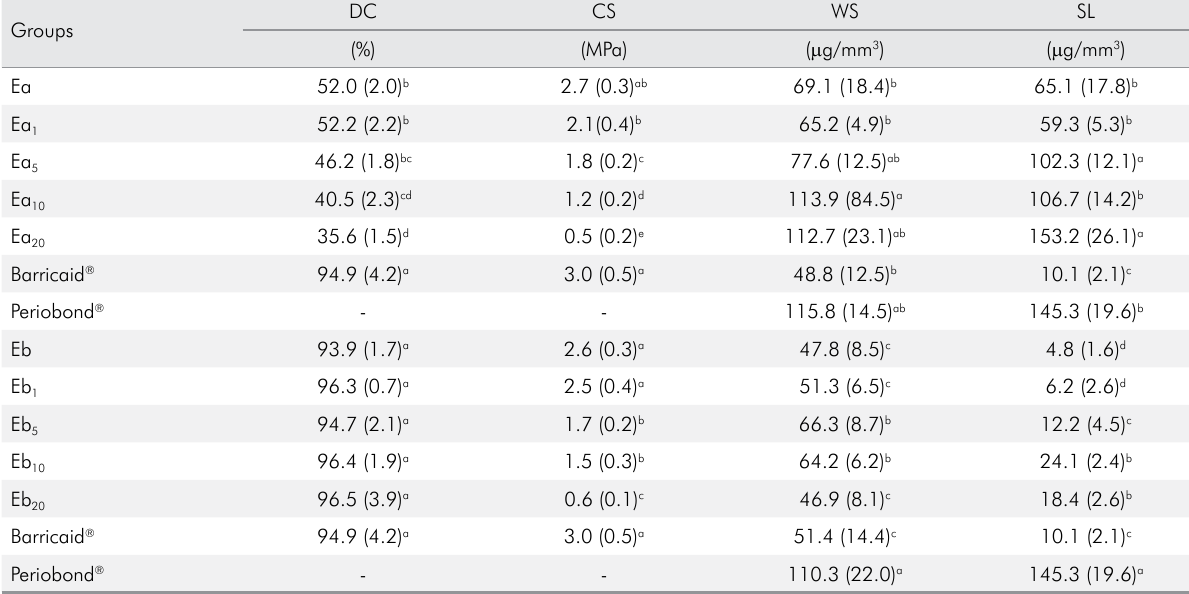
Table 2. Degree of conversion (DC), cohesive strength (CS), water sorption (WS) and solubility (SL) of the tested periodontal dressing. Data are reported as mean (standard deviation)